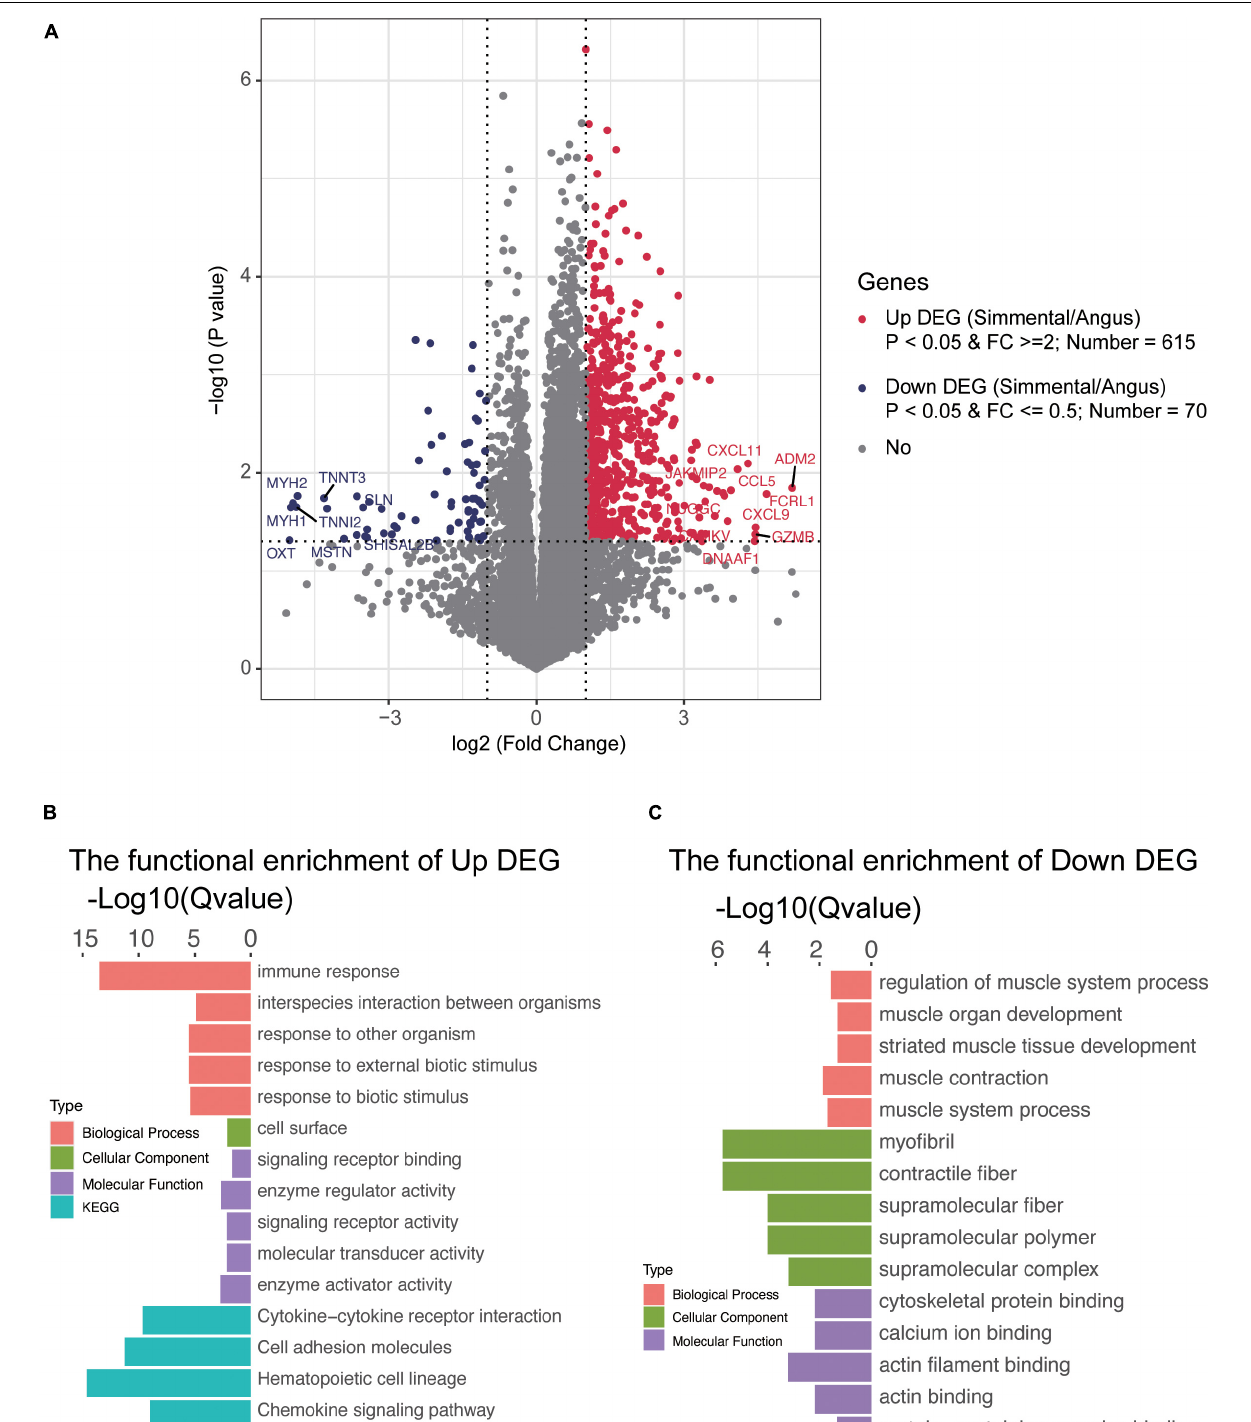
FIGURE 3 | Transcriptomic analysis of the differentially expressed genes (DEGs) and their function in the muscular tissue of Angus and Chinese Simmental cattle. The ratio of Chinese Simmental cattle to Angus cattle (Simmental/Angus) meant up and down. Among the DEGs between the two breeds, 615 genes were upregulated (A) , and their function are shown in (B) ; 70 DEGs were downregulated (A) , and their function are shown in (C) .